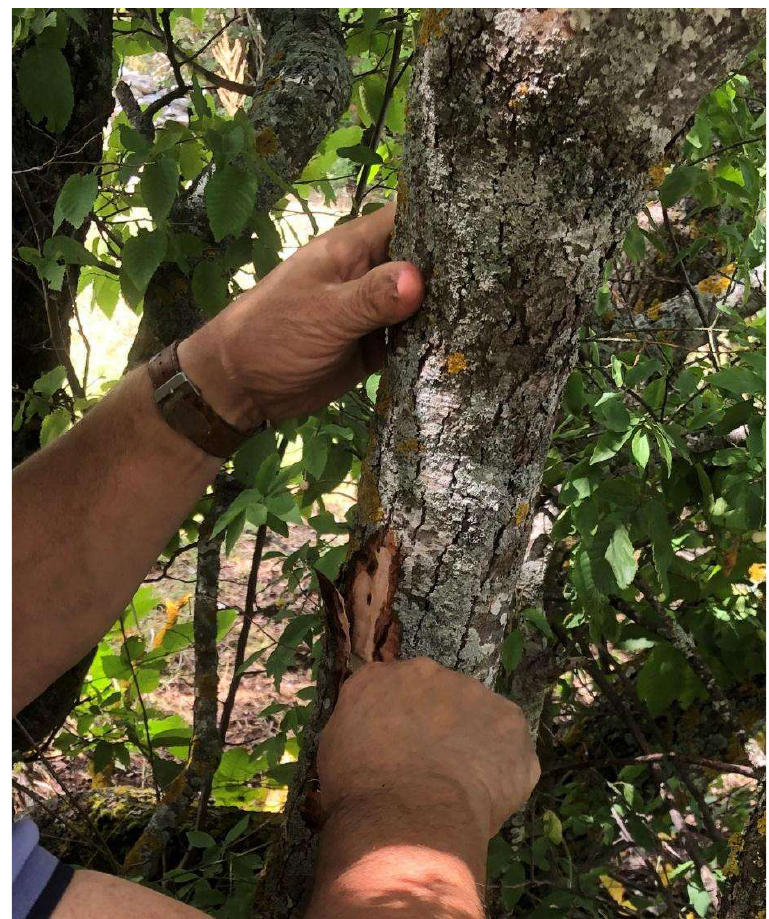
Figure 8. Male study participants from Gurgumicë simulating how the trunk of Carpinus was carved to obtain cambium mixed with sap (Photo: R. Berisha).